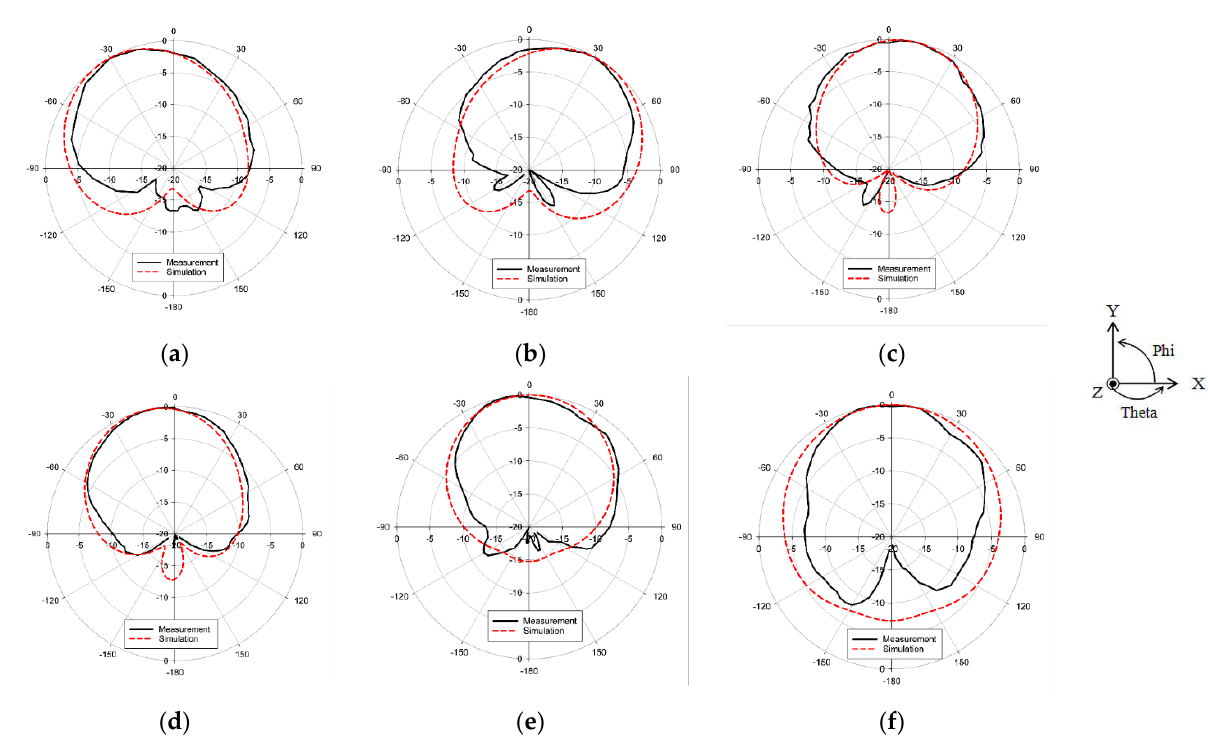
Figure 10. Normalized polar plot for measurement and simulation: ( a ) left ; ( b ) right ; ( c ) top ; ( d ) bottom ; ( e ) all OFF; and ( f ) all ON . Table 3. Summary comparison between the simulated and measured results of the tilting angle for all switch configurations.